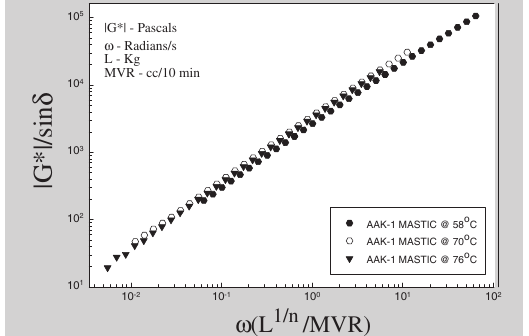
Figure 6 (left): Unified curve of the SHRP parameter |G*|/sin d with modified fre- quency w (L1/n/MVR) cover- ing temperature range of 58˚C - 76˚C for AAK1 mastic unaged sample. Figure 7 (right): Unified curve of the parameter |G*|/sin d with modified fre- quency w (L1/n/MVR) cover- ing temperature range of 70˚C - 87˚C for Styrelf mas- tic unaged